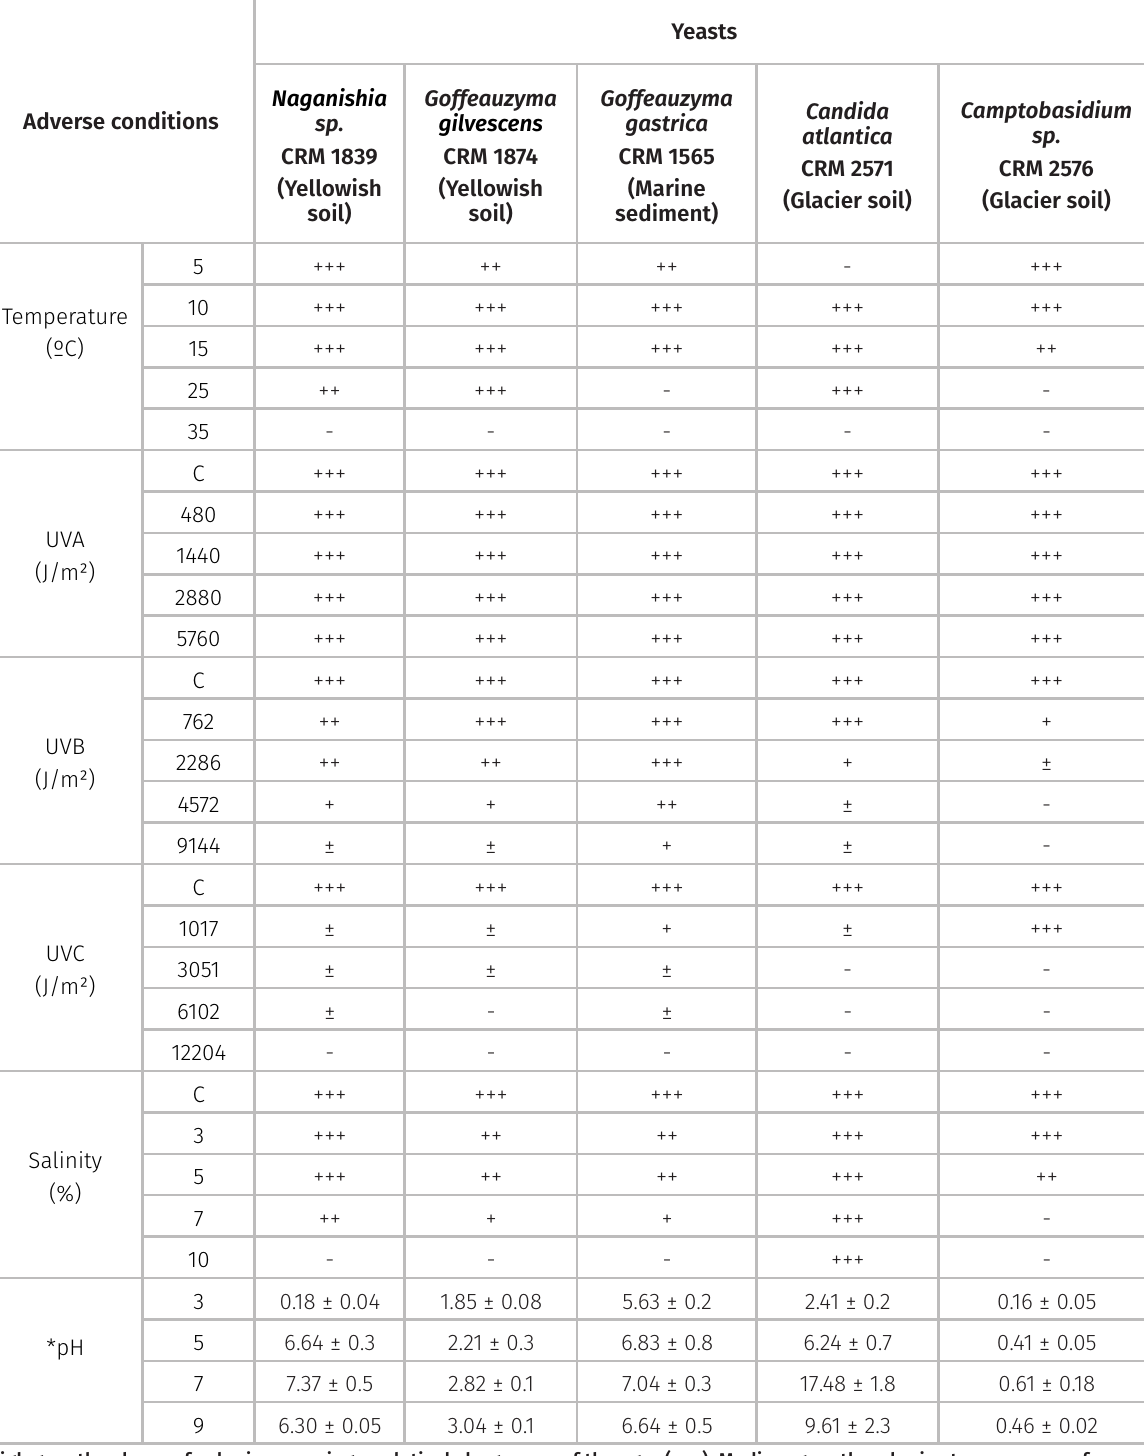
Table II. Response of the Antarctic-derived yeast strains to different adverse conditions (stress factors).